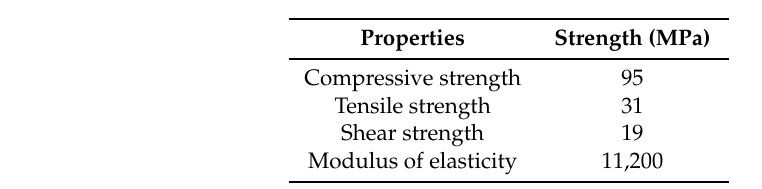
Table 3. Properties of Sikadur ® 30